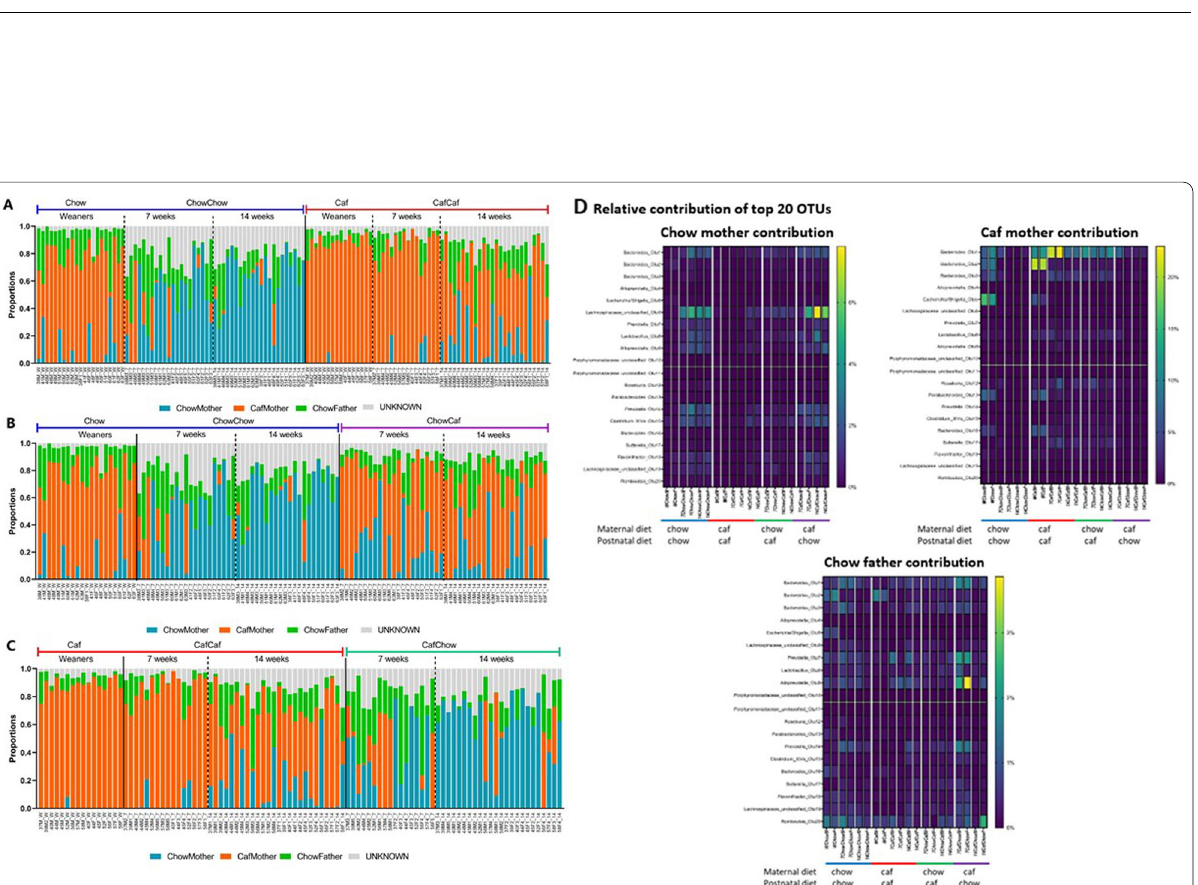
Fig. 6 SourceTracker analyses. Chow mothers, Caf mothers and Chow fathers were pooled separately and computed as sources that can contribute to offspring gut microbial communities. A shows offspring consuming same diet as mother; Chow and Caf weanlings, ChowChow and CafCaf offspring at 7 and 14 weeks. B compares offspring of Chow mothers; Chow weanlings, ChowChow and ChowCaf offspring at 7 and 14 weeks. C compares offspring of Caf mothers; Caf weanlings, CafChow and CafCaf offspring at 7 and 14 weeks. Individual rats are indicated on X axis (number indicates mother id, M or F indicates male or female). D Relative contribution of top 20 OTUs of Chow mother, Caf mother and Chow father gut microbiota to offspring gut